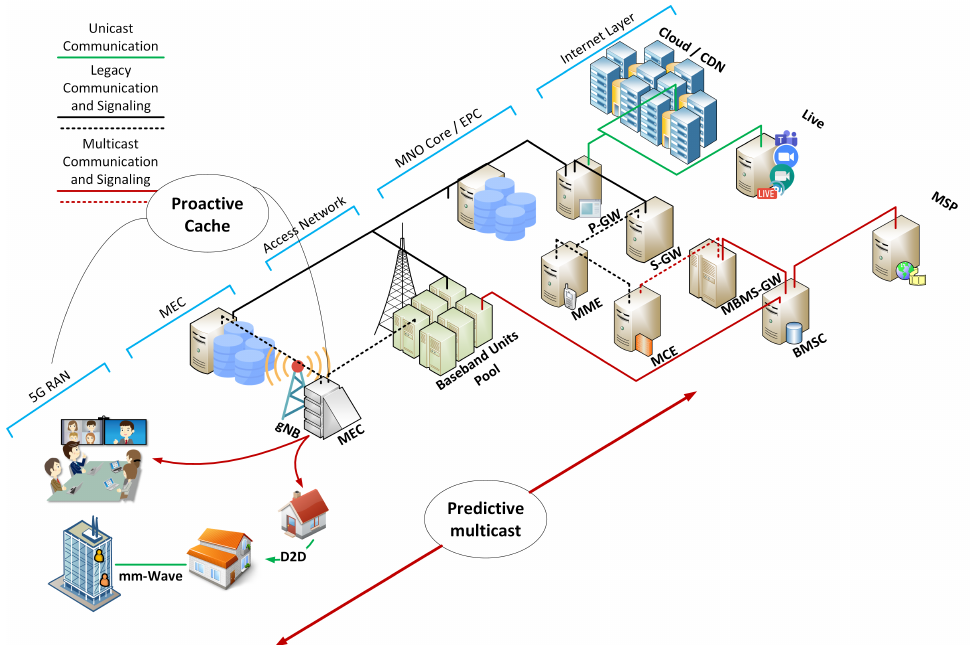
Figure 2. The concept of multi-cast, machine learning, and distance